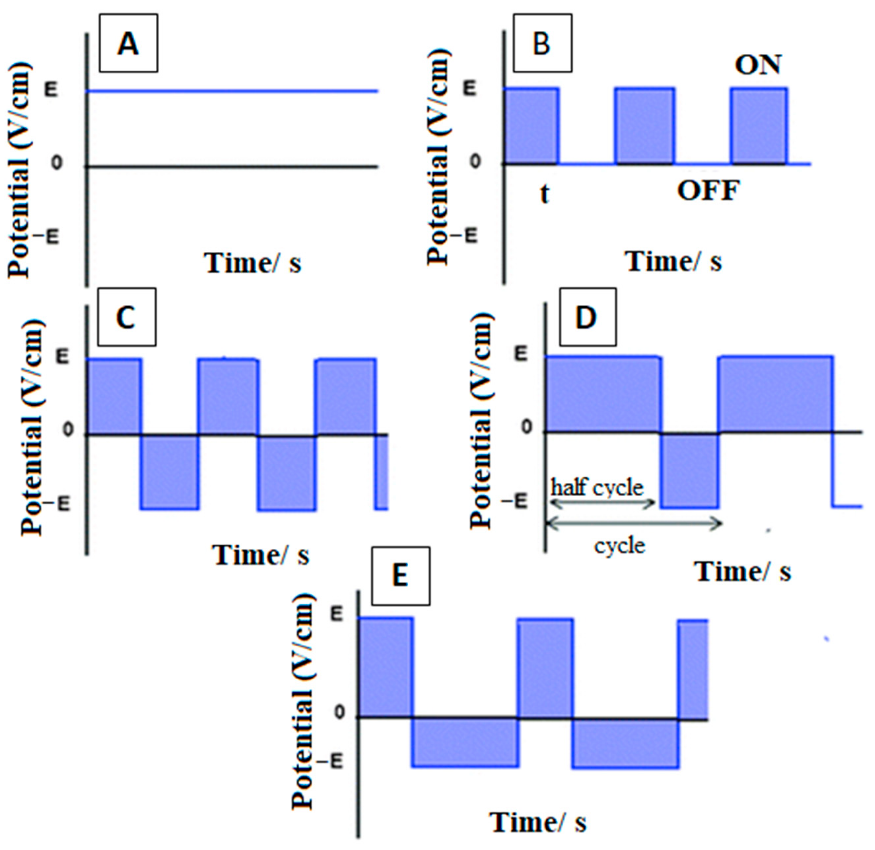
Figure 2. Representation of various types of electric signals: ( A ) DC, ( B ) PDC, ( C – E ) modulated alternating currents. Reproduced from [43] with the permission from the Royal Society of Chemis ‐ try™.